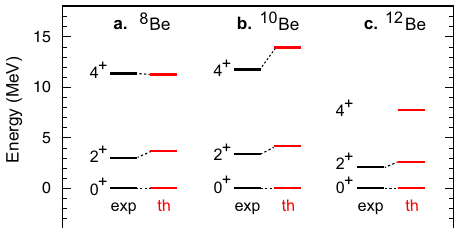
Fig. 2 Excitation level energies of Be isotopes. Theoretical levels ( “ th ” ) are shown for a 8 Be, b 10 Be, and c 12 Be, in comparison to experiment ( “ exp ” ) taken from the National Nuclear Data Center ’ s “ Evaluated Nuclear